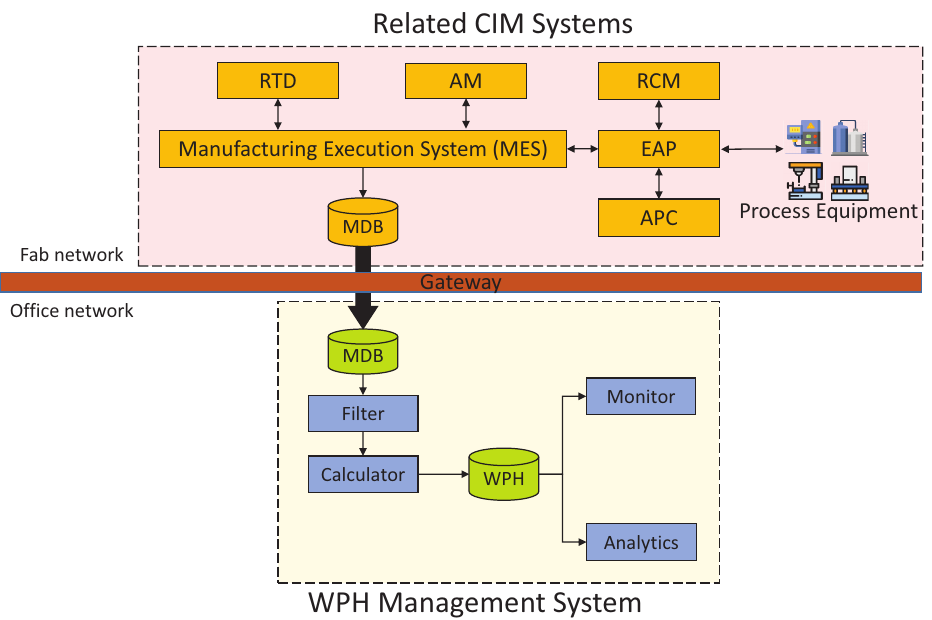
Figure 7. Systems architecture. CIM, computer-integrated manufacturing; RTD, real-time dispatcher; AM, activity manager; RCM, recipe control management; EAP, equipment automation program; MDB, master database; APC, advance process